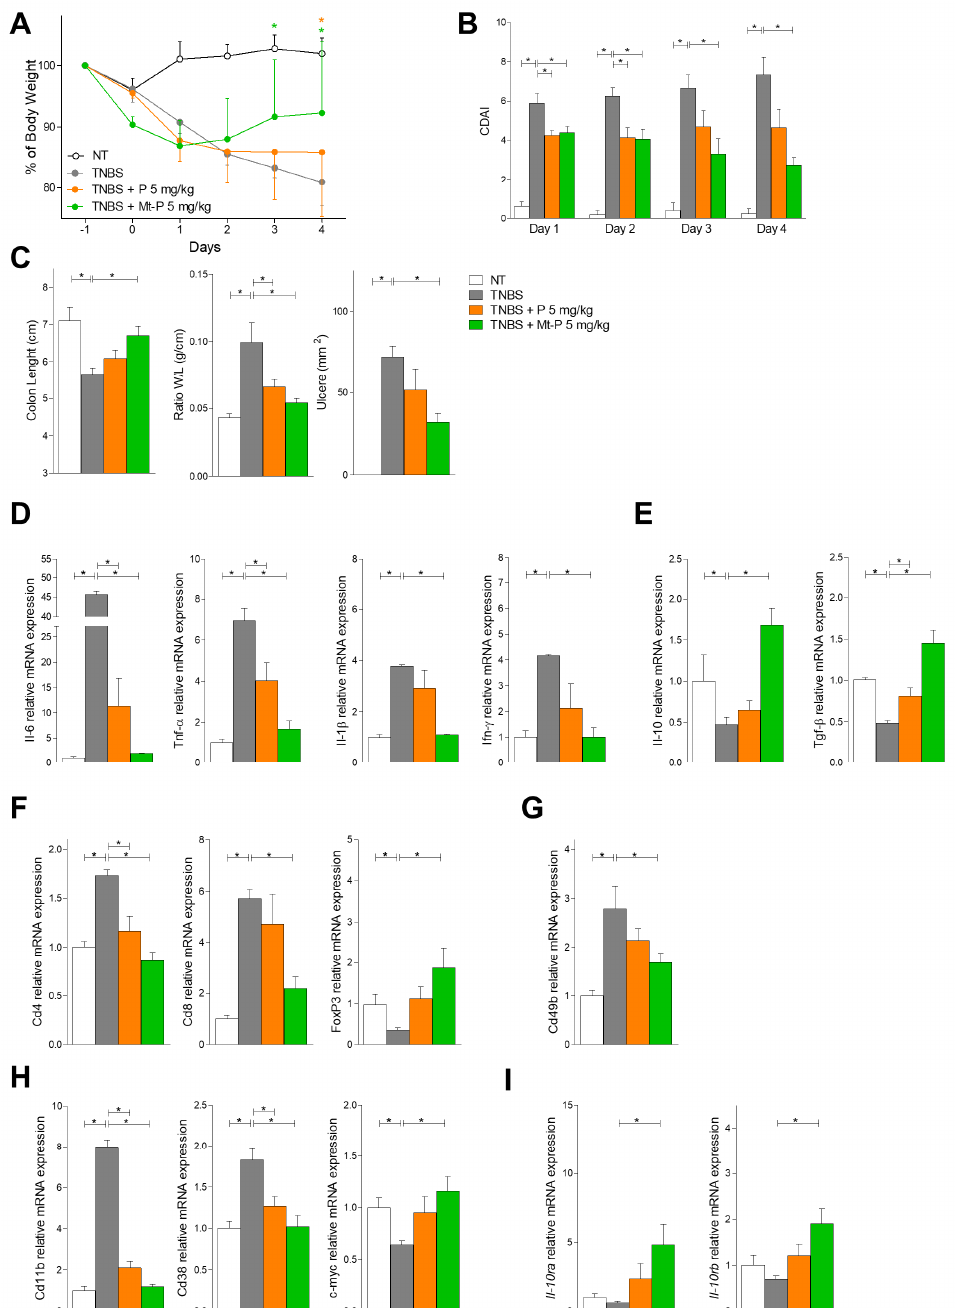
Figure 4. Mt-P is more e ff ective than P in reducing the severity of colitis. Balb / C mice were treated with TNBS alone or in combination with P or Mt-P (5 mg / kg) as described before (see Section 2). ( A ) Changes in body weight and ( B ) Colitis Disease Activity Index (CDAI) of mice during the course of TNBS-induced colitis. ( C ) Analysis of the intestinal inflammatory score: Colon length ( left ), ratio of colon weight / colon length ( central ), and ulcers ( right ). Relative mRNA expression of pro-inflammatory cytokines ( D ) Il-6, Tnf- α , Il-1 β , and Ifn- γ , ( E ) anti-inflammatory cytokines Il-10 and Tgf- β , ( F ) T cell markers Cd4, Cd8 , and FoxP3 , ( G ) NK and NKT markers Cd49b , ( H ) macrophages markers Cd11b, Cd38 , and c-myc , and ( I ) Il-10ra and Il-10rb genes in the colons of mice assessed by real-time PCR. Values are normalized relative to Gapdh mRNA and are expressed as mean ± SEM of five / eight mice per group (NT = 5; TNBS = 8; TNBS + P 5 mg / kg = 6; TNBS + Mt-P 5 mg / kg = 8) (* p <